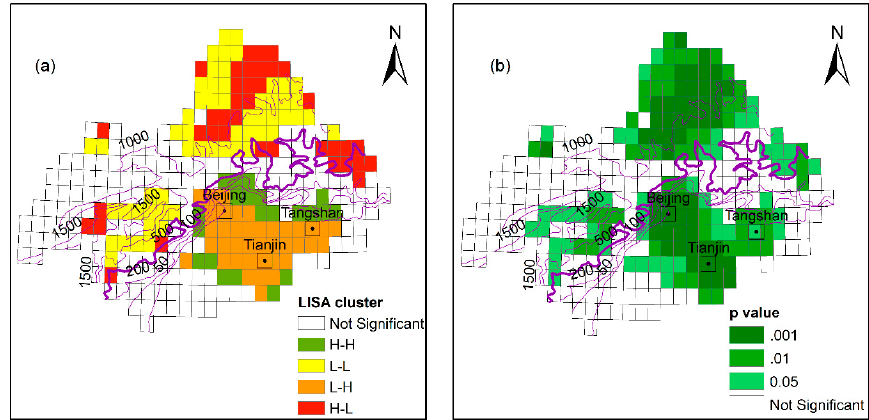
Figure 7. Local indicators of spatial association (LISA) cluster ( a ) and significance ( b ) map for LIEP versus urban level.